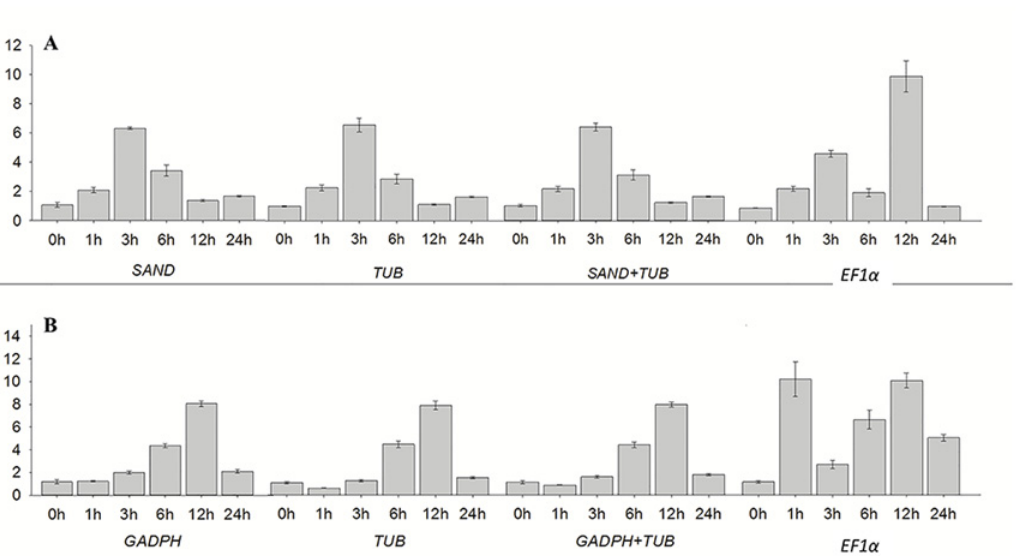
Fig 5. Relative expression of FaWRKY1 using selected reference genes including the most ( SAND and TUB ) and the least ( EF1 α ) stable reference genes for normalization, following the stress treatment after 0, 1, 3, 6, 12 and 24 h. (A) FaWRKY1 expression of roots under salt-stress; (B) FaWRKY1 expression of leaves under drought-stress (PEG treatment). The error bars represent standard